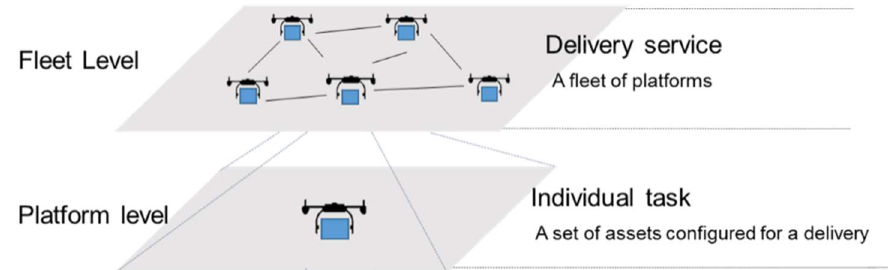
Figure 1. Overall hierarchical representation of the system related to the problem.